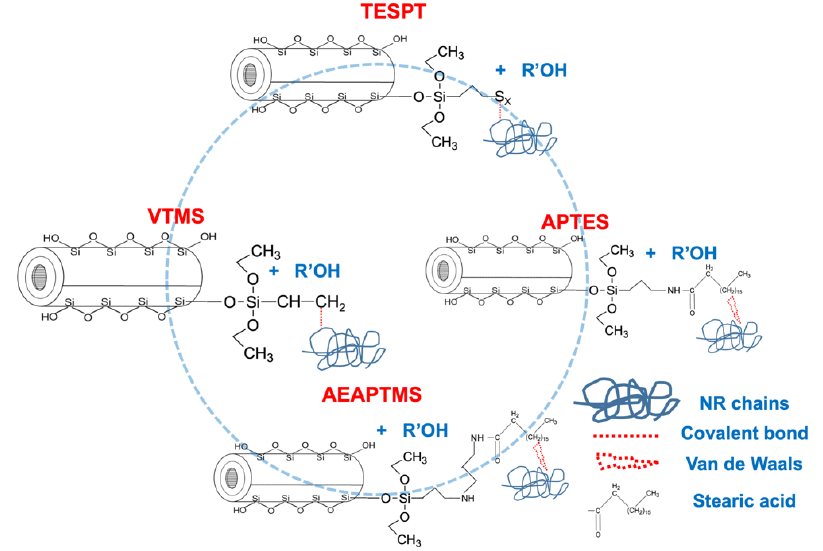
Figure 4. Proposed mechanisms of HNT and silane coupling agents.